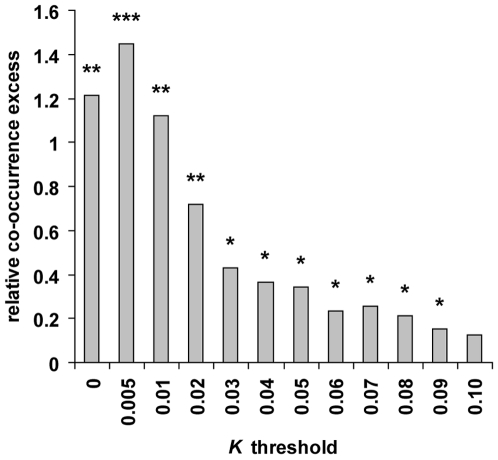
Human and other primate orthologous genes co-occur in selective
sweeps more often than expected by chance.The relative co-occurrence excess (observed score/expected score
–1) between human and other primate candidates was measured
for several upper thresholds of K ranging from 0 to
0.1. *: P≤5.10−2.
**: P≤10−2.
***:
P≤10−3.